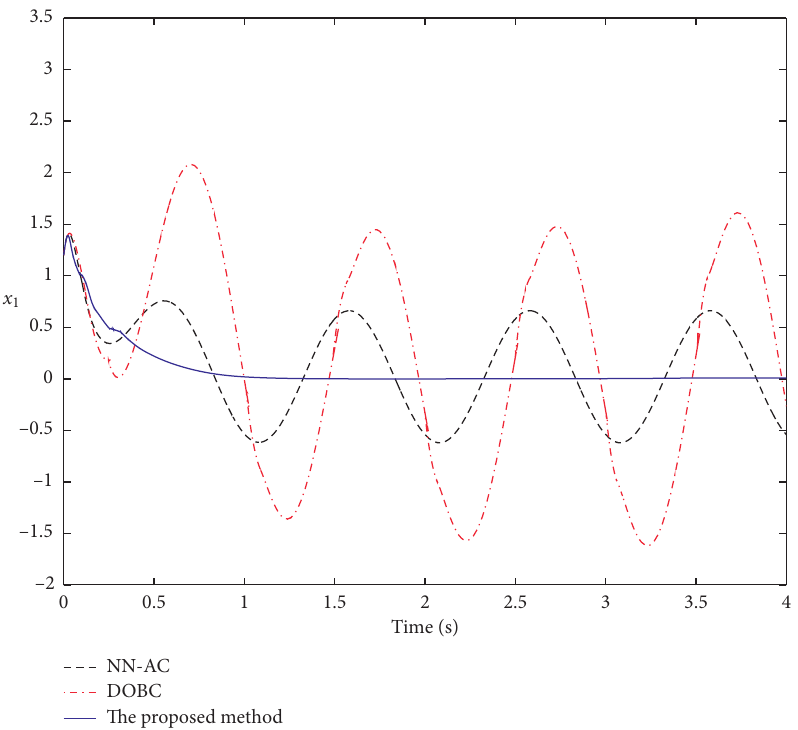
Figure 1: The trajectories of the system state x